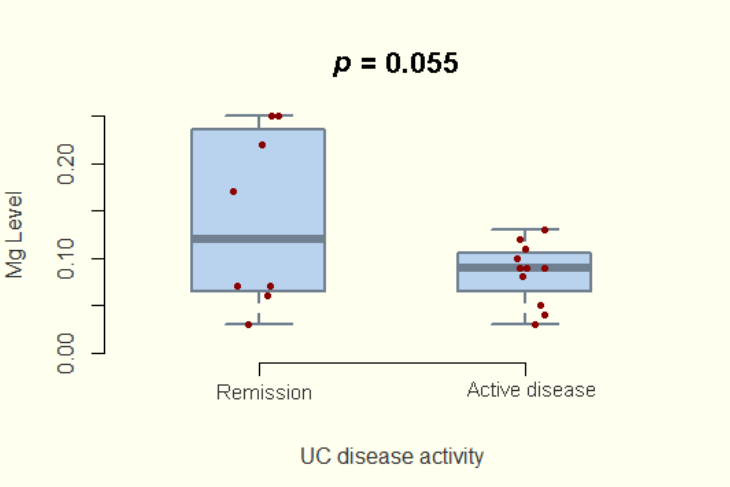
Figure 2. Evaluating the difference in hair magnesium concentration for UC patients based on disease activity .